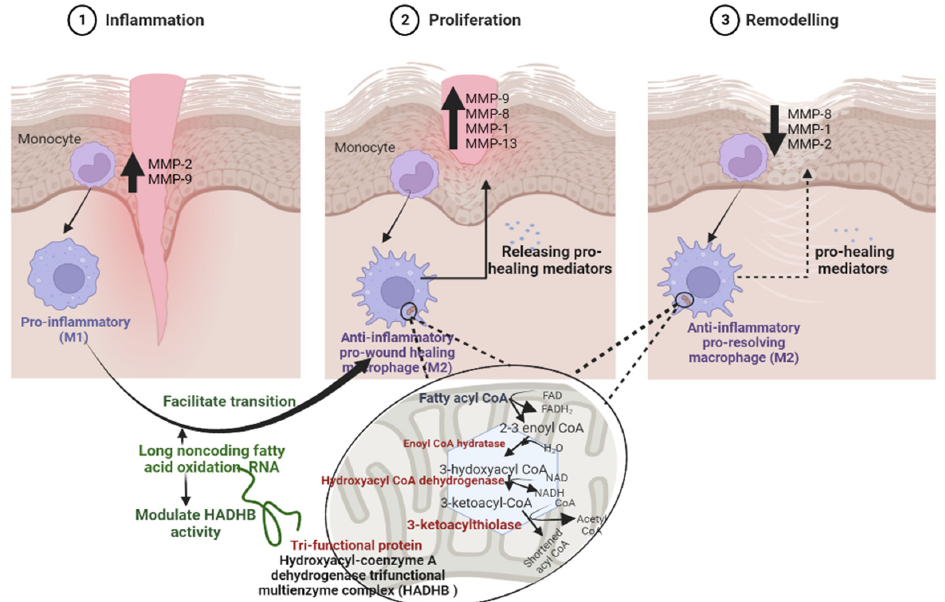
Figure 5. A schematic presentation of macrophage driven acute wound healing. During its three phases; inflammation, proliferation and remodeling. Pro-inflammatory macrophages phagocytose cellular debris and pathogens and release proinflammatory cytokines along with proteolytic enzymes, including metalloproteinases, especially MMP-2, and MMP-9. The macrophage populations begin transitioning to anti-inflammatory pro-wound healing macrophages; this transition is up-regulated by lncFAO that secrete factors, including metalloproteinases, especially MMP-1, MMP-8, MMP-9, that enhance vascular formation, granulation tissue formation, collagen deposition, and re-epithelialization. The anti-inflammatory pro-resolving macrophages enhance granulation tissue breakdown, allow collagen maturation, and improve regenerated skin strength along with down-regulation of a variety of MMPs, including MMP-9. Below the diagram, the main mechanism of lncFAO during the macrophage transition process through activating the β -subunit of mitochondrial trifunctional protein (hydroxyacyl-CoA dehydrogenase/3-ketoacyl-CoA thiolase/enoyl-CoA hydratase β -subunit; HADHB), a keyenzyme in fatty acid oxidation.